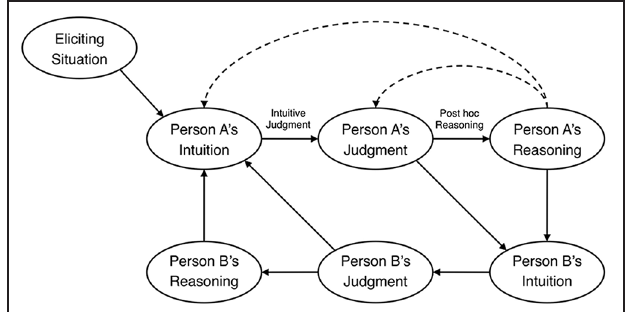
FIGURE 4 | Haidt’s Social Intuitionist Model of moral judgment. Reprinted from Haidt (2001) with permission from